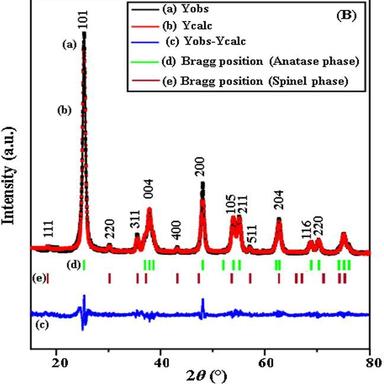
(a) XRPD diffraction patterns of the novel photocatalysts; (b) Rietveld refinement of the TCF nanocomposites. Overall goodness of fit: χ2 = 2.32.